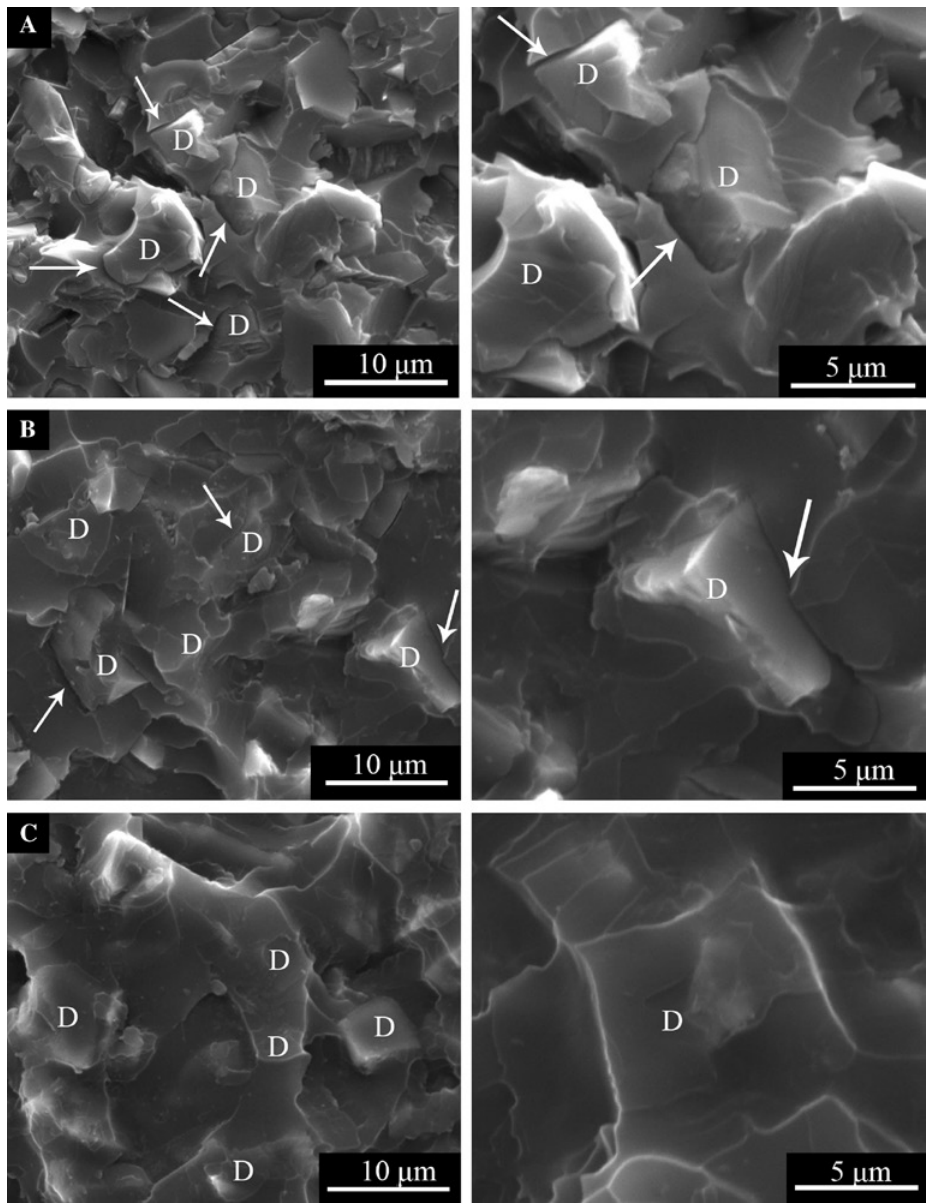
Figure 8: SEM micrograph of fracture surface of diamond/resin composite (A) sample with pristine diamond, (B) sample with KH550 modi- fied diamond in aqueous alcohol, (C) sample with KH550 modified diamond in toluene; D represents diamond particles. The white arrows in (A) and (B) indicate